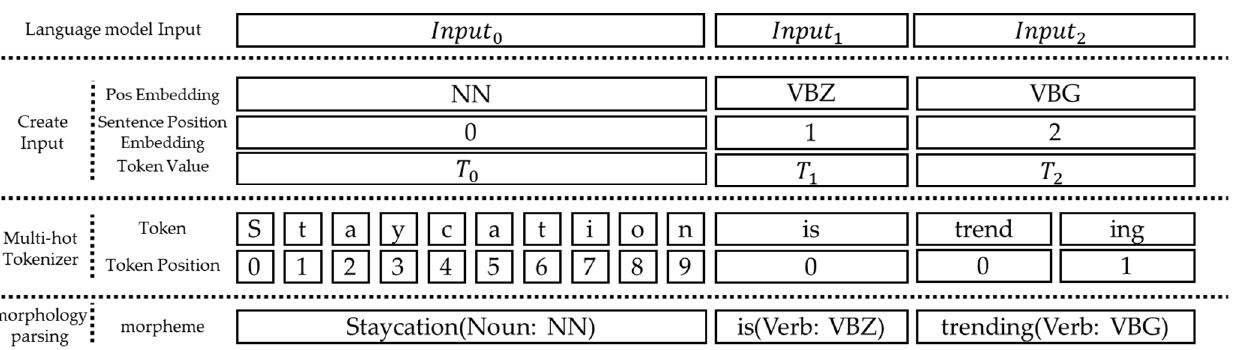
Figure 1. The multi-hot representation language model acting on an input value (on the example: “Staycation is trending”).